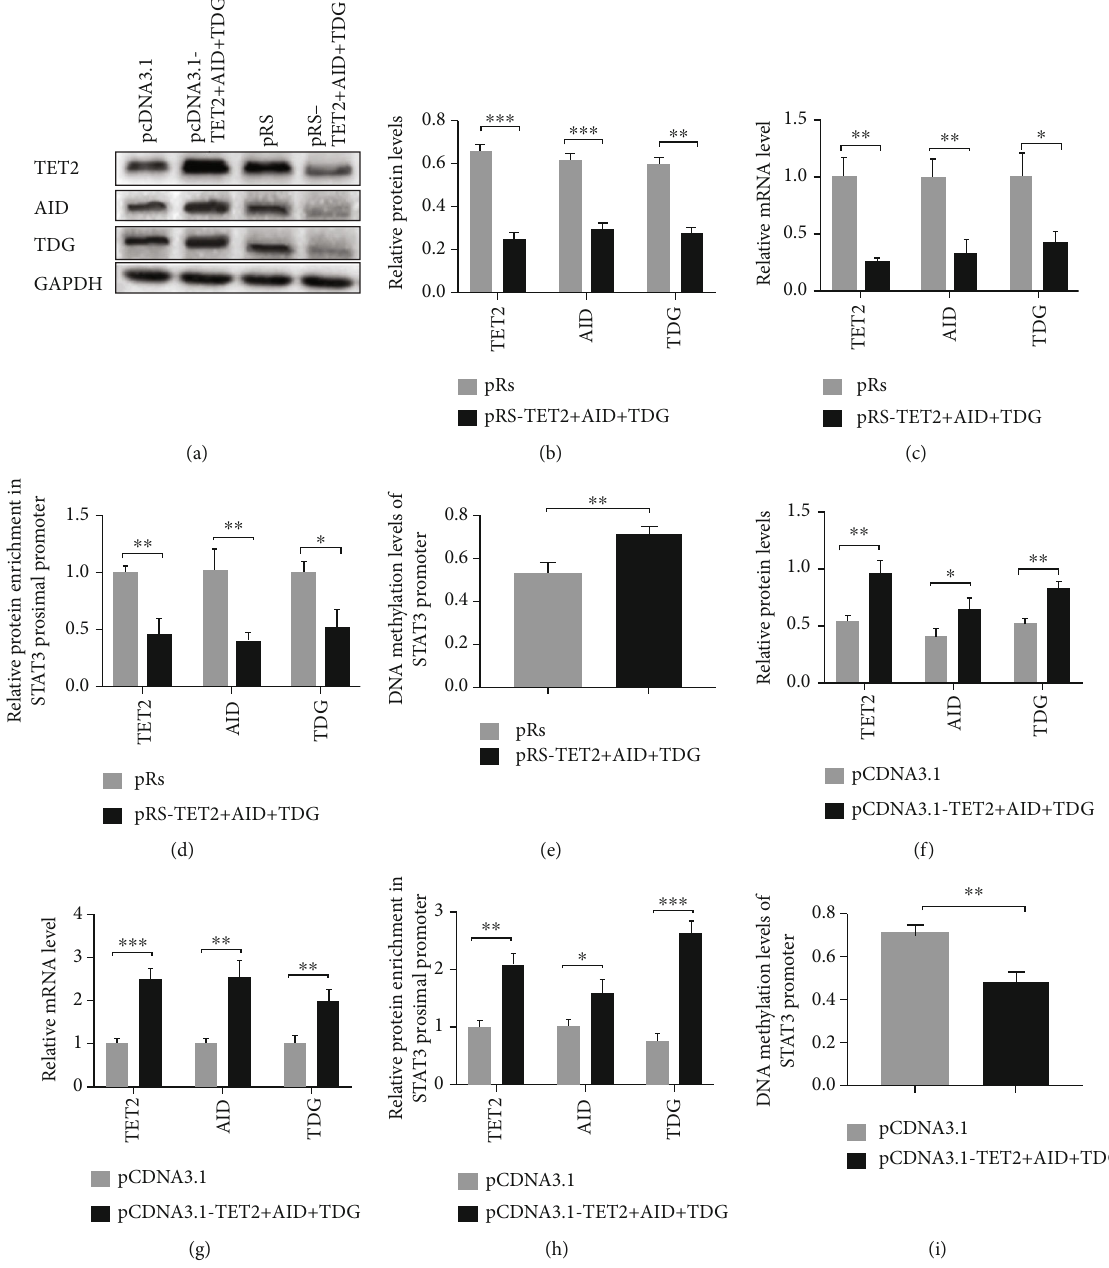
Figure 3: Interference with TET2/AID/TDG in aGVHD CD4 + T cells could induce DNA hypermethylation of STAT3 promoter. (a) Representative Western blot results for TET2, AID, TDG, and GAPDH levels. (b), (c) Quantitative analysis of the (b) relative protein levels and (c) relative mRNA levels of TET2, AID, and TDG in aGVHD CD4 + T cells transfected with TET2/AID/TDG interference plasmids or control plasmid. (d), (e) The binding levels of (d) TET2/AID/TDG in STAT3 promoter and (e) DNA methylation level of STAT3 promoter in TET2/AID/TDG-de fi cient aGVHD CD4 + T cells or control aGVHD CD4 + T cells. (f), (g) Quantitative analysis of the (f) relative protein levels and (g) relative mRNA levels of TET2, AID, and TDG in non-aGVHD CD4 + T cells transfected with TET2/AID/TDG overexpression plasmids or control plasmids. (h), (i) (h) The binding levels and (i) DNA methylation level in TET2/AID/TDG overexpressed non-aGVHD CD4 + T cells or control cells. Data represent the mean of three independent experiments ( 0 = unmethylated ; 0 : 5 = 50 % methylated ); ∗ p < 0 : 05 , ∗∗ p < 0 : 01 , ∗∗∗ p < 0 : 001